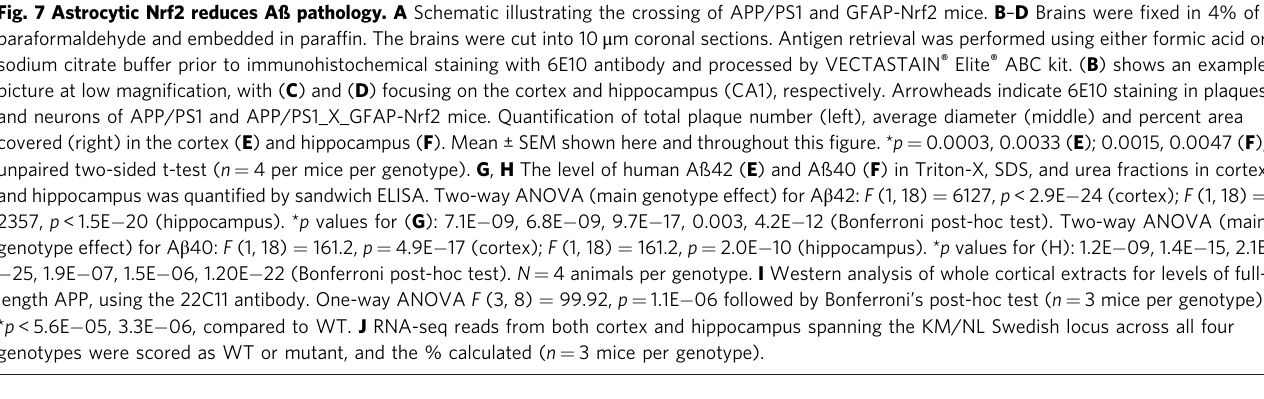
Fig. 7 Astrocytic Nrf2 reduces Aß pathology. A Schematic illustrating the crossing of APP/PS1 and GFAP-Nrf2 mice. B – D Brains were fi xed in 4% of paraformaldehyde and embedded in paraf fi n. The brains were cut into 10 μ m coronal sections. Antigen retrieval was performed using either formic acid or sodium citrate buffer prior to immunohistochemical staining with 6E10 antibody and processed by VECTASTAIN ® Elite ® ABC kit. ( B ) shows an example picture at low magni fi cation, with ( C ) and ( D ) focusing on the cortex and hippocampus (CA1), respectively. Arrowheads indicate 6E10 staining in plaques and neurons of APP/PS1 and APP/PS1_X_GFAP-Nrf2 mice. Quanti fi cation of total plaque number (left), average diameter (middle) and percent area covered (right) in the cortex ( E ) and hippocampus ( F ). Mean ± SEM shown here and throughout this fi gure. * p = 0.0003, 0.0033 ( E ); 0.0015, 0.0047 ( F ), unpaired two-sided t-test ( n = 4 per mice per genotype). G , H The level of human Aß42 ( E ) and Aß40 ( F ) in Triton-X, SDS, and urea fractions in cortex and hippocampus was quanti fi ed by sandwich ELISA. Two-way ANOVA (main genotype effect) for A β 42: F (1, 18) = 6127, p < 2.9E − 24 (cortex); F (1, 18) = 2357, p < 1.5E − 20 (hippocampus). * p values for ( G ): 7.1E − 09, 6.8E − 09, 9.7E − 17, 0.003, 4.2E − 12 (Bonferroni post-hoc test). Two-way ANOVA